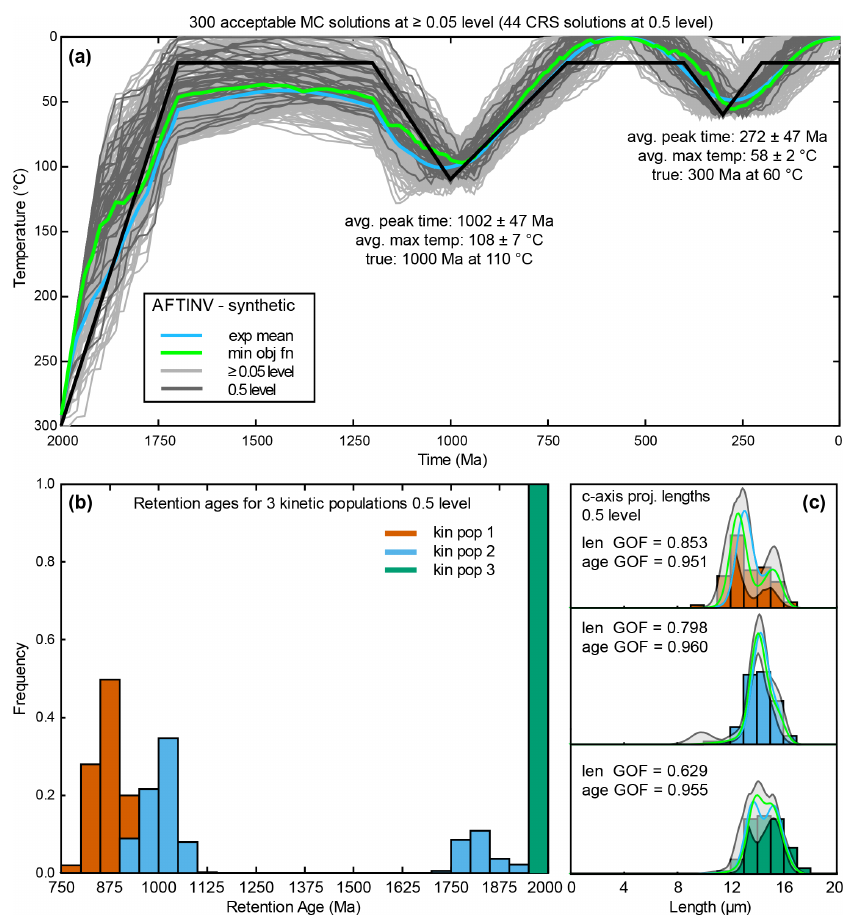
Figure 6. (a) AFTINV software thermal-history inversion results using random MC and the CRS algorithms (e.g., Willett, 1997; McDannell et al., 2019b). Model in (a) was set up to find 300 random MC solutions at the 0.05 fit level (not shown), which are then used as a “seed” pool for the CRS algorithm to iteratively recombine and refine the solution set to the better 0.5 statistical fit level. In this example, not all solutions reached the 0.5 significance level (only 44 did; dark grey lines) and are therefore ≥ 0.05 level (light grey lines). The exponential mean t – T path is shown for all 300 solutions (blue line) along with the “minimum objective function” or overall best-fit solution (green line). (b) Retention ages or hypothetical age of the oldest retained fission tracks (2µm) for each kinetic population. Retention ages give a rough sense of temperature sensitivity. (c) Track length distribution model fits for the exponential mean and minimum objective function t – T paths for each kinetic population. Observed versus predicted goodness of fit (GOF) for AFT age and track length for the minimum objective function solution. See McDannell et al. (2019b) for further discussion of AFTINV modelling